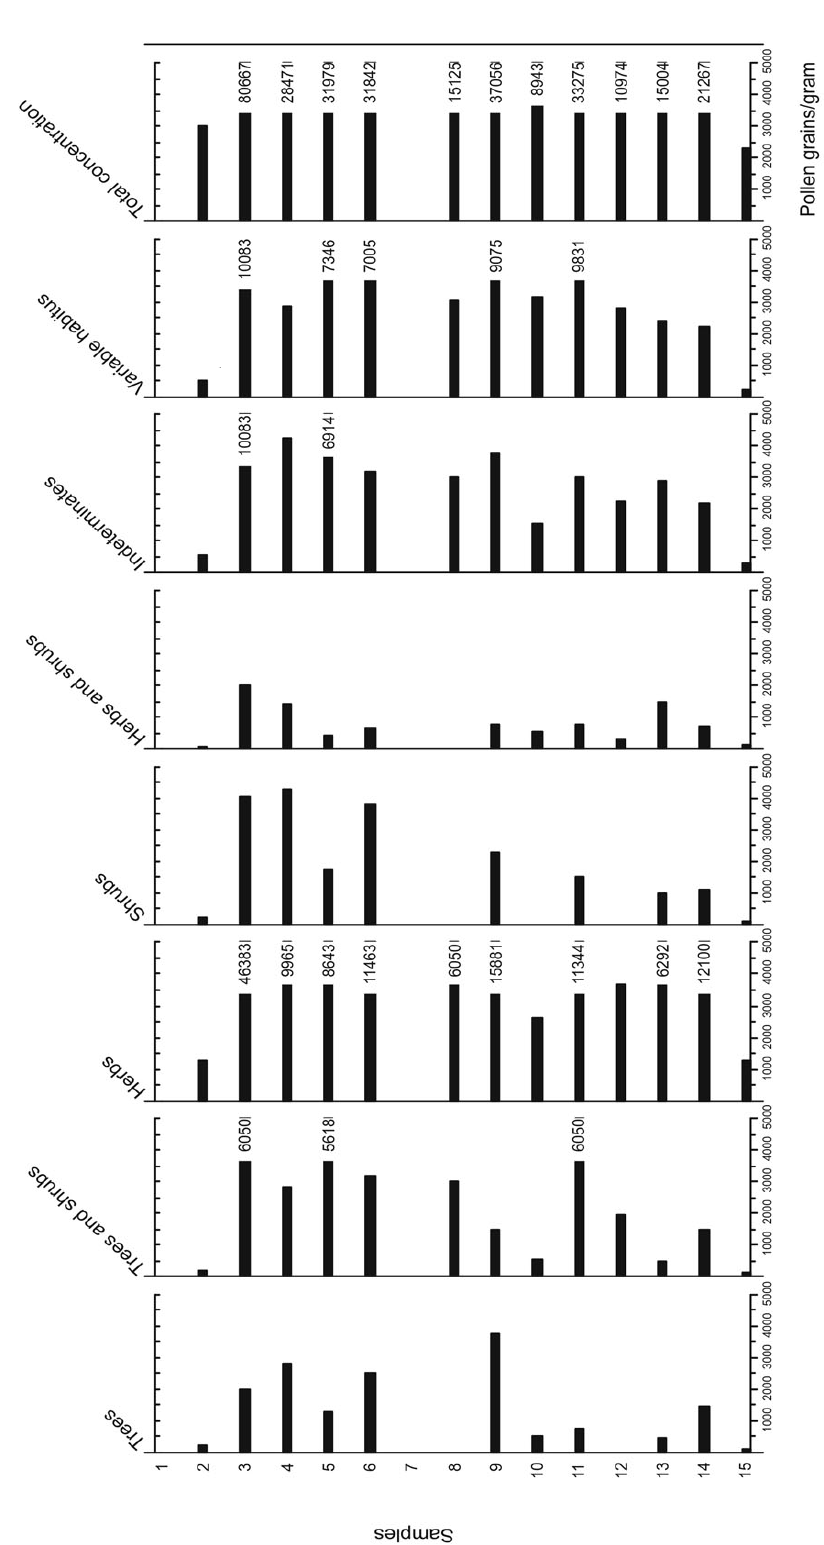
Fig. 4 – Total concentration of pollen grains according to the plant habitus in the surface samples of the Lagoa de Cima